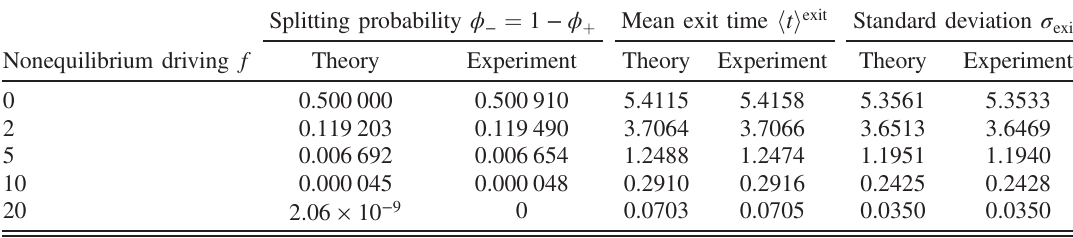
TABLE VI. Comparing theory to simulation. Nonequilibrium driving is quantified in terms of f ≡ M × 120 ° = ð k T Þ . The theoretical values for the splitting probability follow from Eq. (E3). By evaluating B the auxiliary integrals in Eq. (9) and using Eqs. (S47) and (S50) in the Supplemental Material [75], we obtain the theoretical values for mean first exit time h t i exit and the second moment of the exit time h t 2 i exit , and therefrom the standard deviation σ exit ¼ backward transition is observed in 500 000 trajectories, which is why we experimentally determine ϕ − ¼ 0